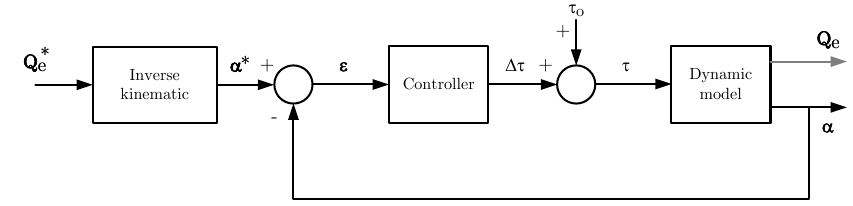
Figure 7. Final control approach for end-effector